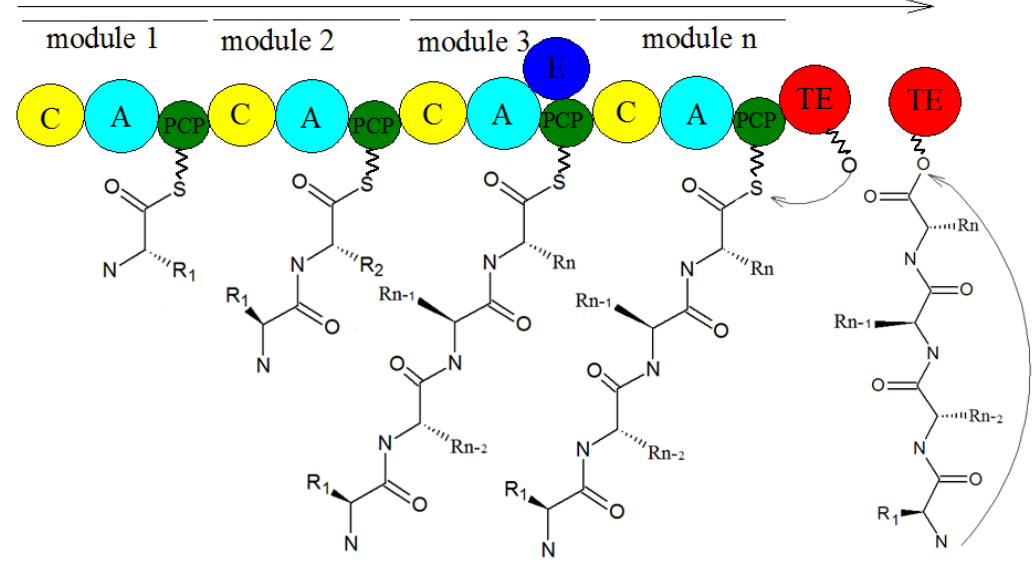
Figure 11. The biosynthesis of NRPSs [76] .